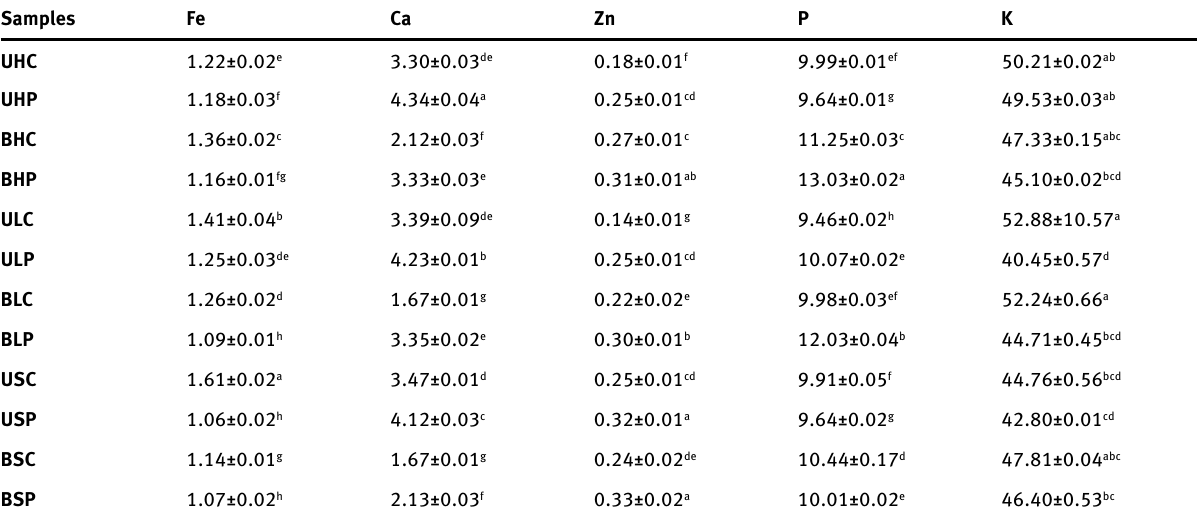
Table 3: Minerals content (mg/100g) of cardaba banana and plantain flours